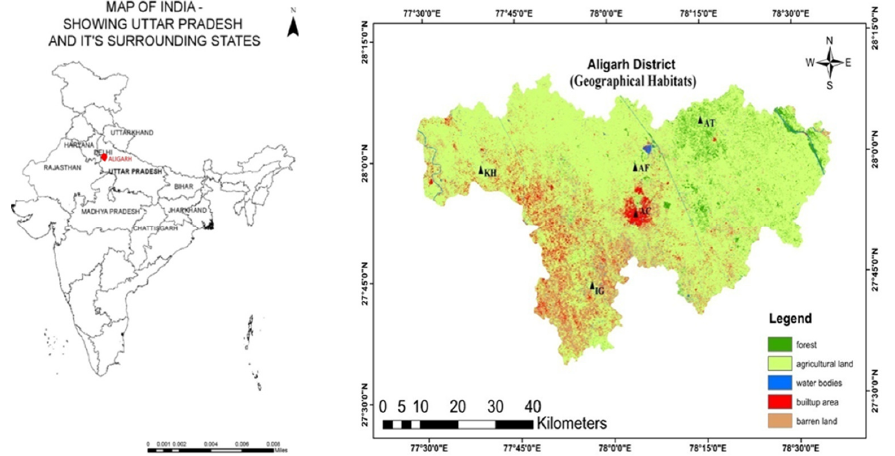
Figure 1. Maps of India and sampling sites of Aligarh district